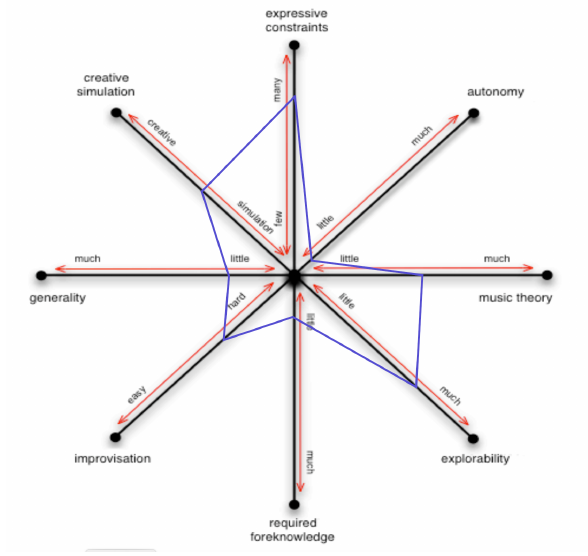
Figure 9. The AudioVirtualizer plotted